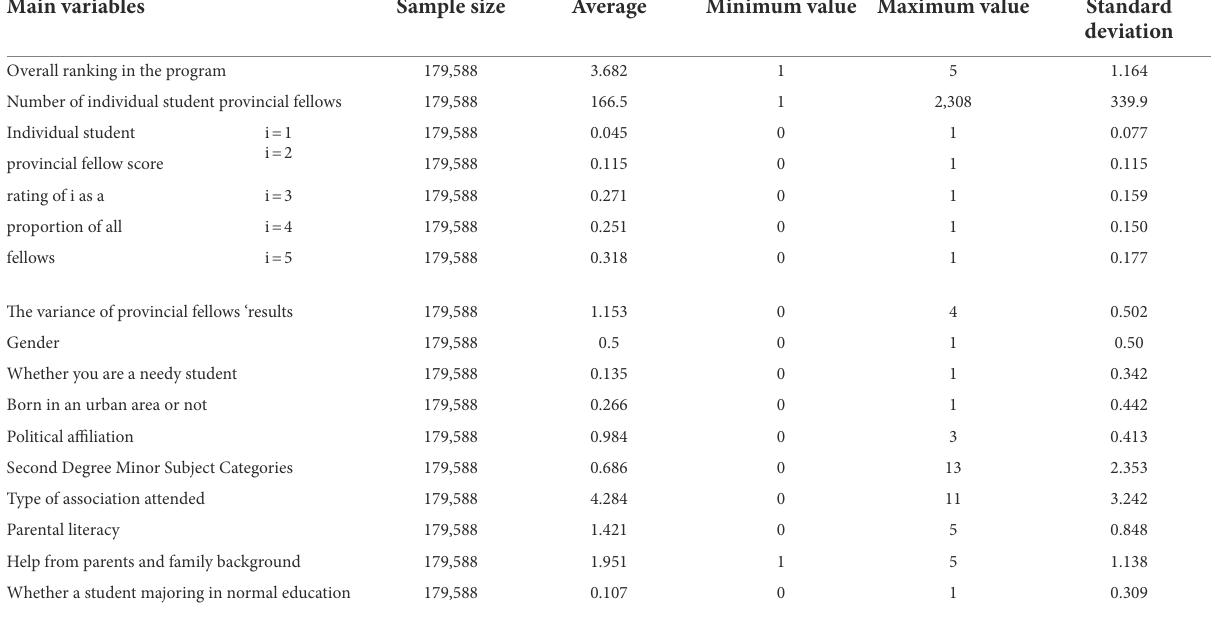
TABLE 2 Descriptive statistics (provincial).